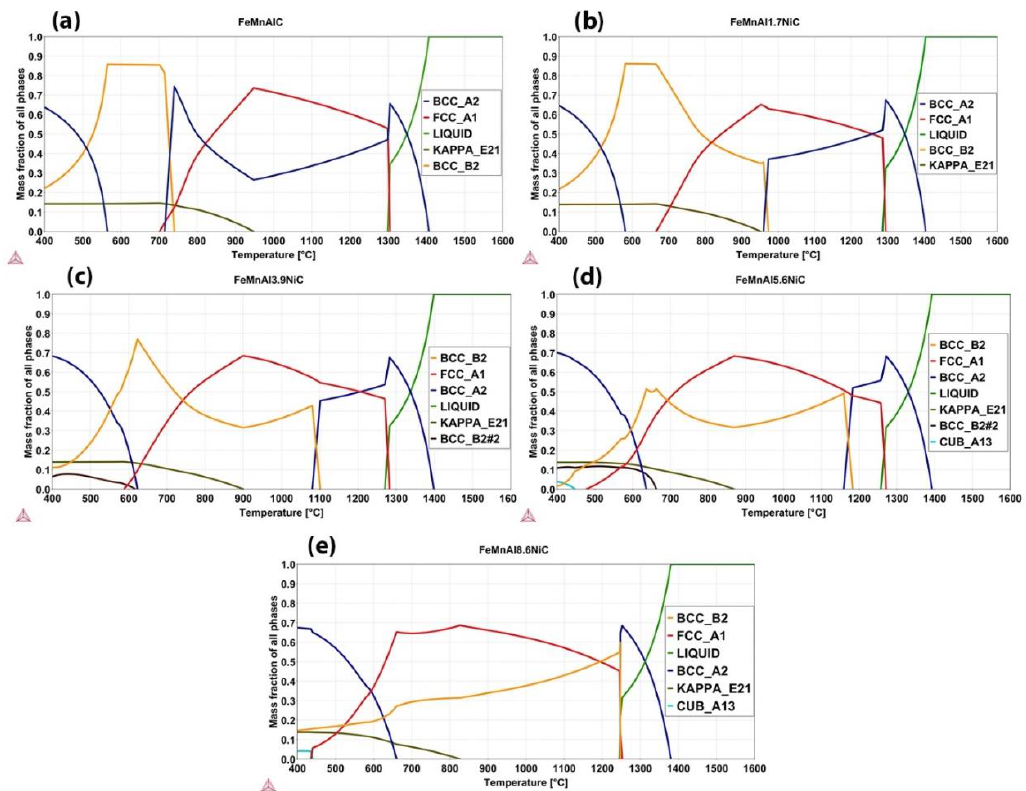
Figure 1. CALPHAD calculations of the equilibrium amount of phases in the steels studied, ( a ) FeMnAlC, ( b ) FeMnAl1.7NiC, ( c ) FeMnAl3.9NiC, ( d ) FeMnAl5.6NiC, and ( e ) FeMnAl8.6NiC.